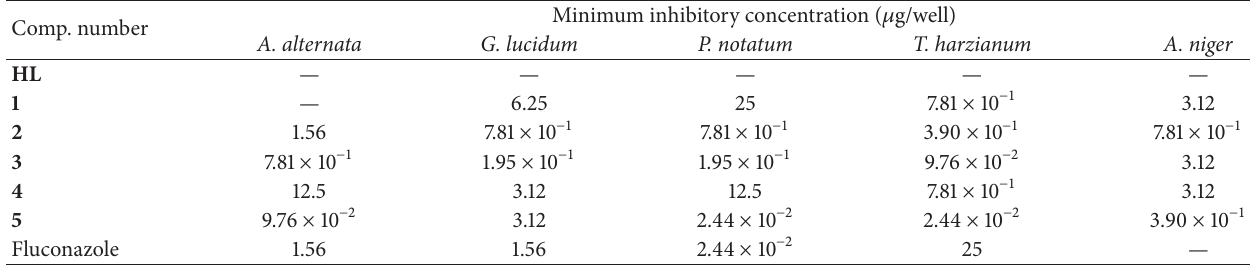
Table 13: MIC (fungal) of organotin complexes 1–5